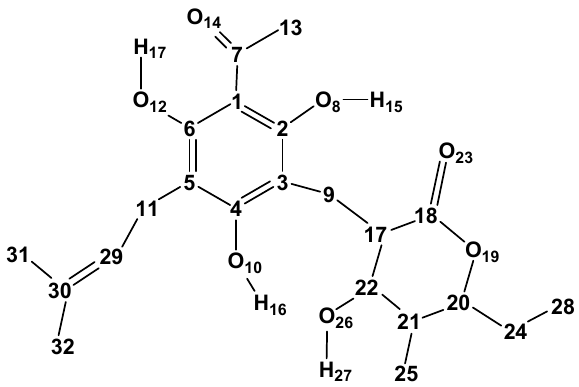
Figure 1. Structure of the arzanol molecule and atom numbering utilised in this work. The figure shows the carbon skeleton of the molecule, the O atoms, and the H atoms pertaining to OH groups. The other H atoms are hidden, to better highlight the molecular structure. The C atoms are denoted by their numbers.